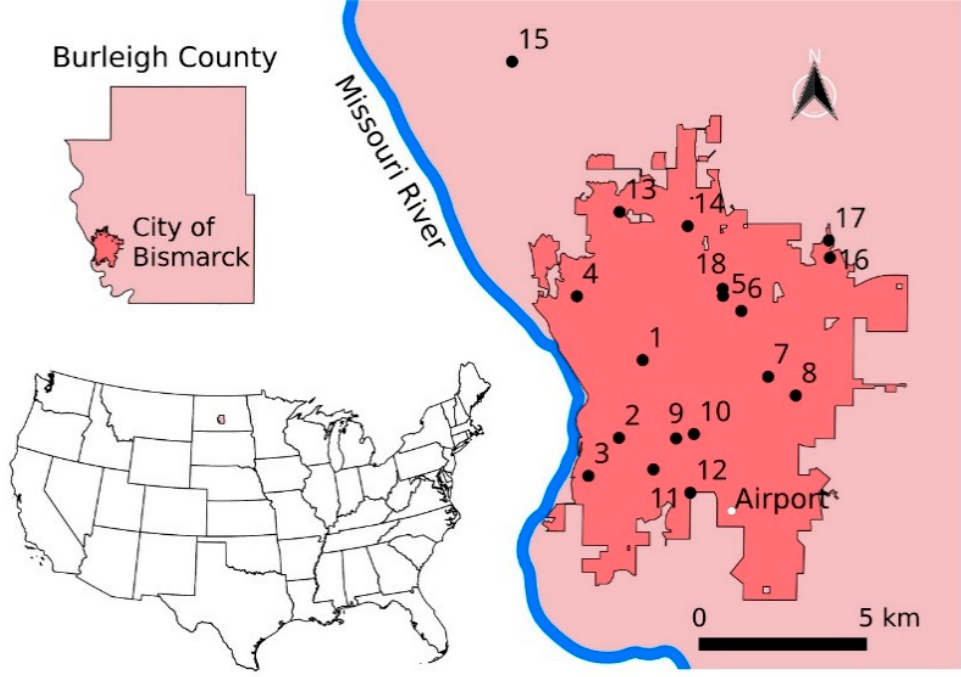
Figure 1. Maps showing the human disease surveillance area and the locations of mosquito traps. The numbers indicate the locations of mosquito traps. Location 15 is located outside of the city of Bismarck although it is still within the metropolitan area. The map was created using multiple shapefiles obtained from the United States Census Bureau [29] and the North Dakota GIS Hub Data Portal [30–34].